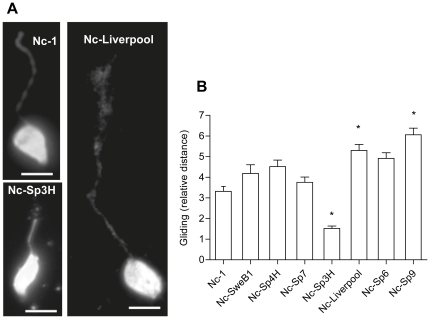
Gliding motility by N. caninum tachyzoites.
A. N. caninum deposited surface membrane trails during gliding on a solid substrate. Trails were visualized by staining with anti-SAG1 mAb. Representative micrographs of Nc-1, Nc-Spain 3H and Nc-Liverpool trails are shown. Scale bar: 5 µm. B. N. caninum isolates exhibit significant differences in gliding motility (P<0.0001; one-way ANOVA test), being highest for Nc-Spain 9 (Nc-Spain 9 versus Nc-1, Nc-SweB1, Nc-Spain 3H and Nc-Spain 7; P<0.05-0.0001; Bonferroni's post-test), and lowest for Nc-Spain 3H (Nc-Spain 3H versus all isolates; P<0.05-0.0001; Bonferroni's post-test). The mean length of trails formed by Nc-Liverpool was also superior to that of Nc-1 (P<0.05; Bonferroni's post-test). Trails were measured as relative parasite body lengths. Ten to fifteen trails were measured per strain per experiment. Mean (±SEM) of the determinations from three independent experiments is represented. Asterisks indicate isolates which showed significant differences.